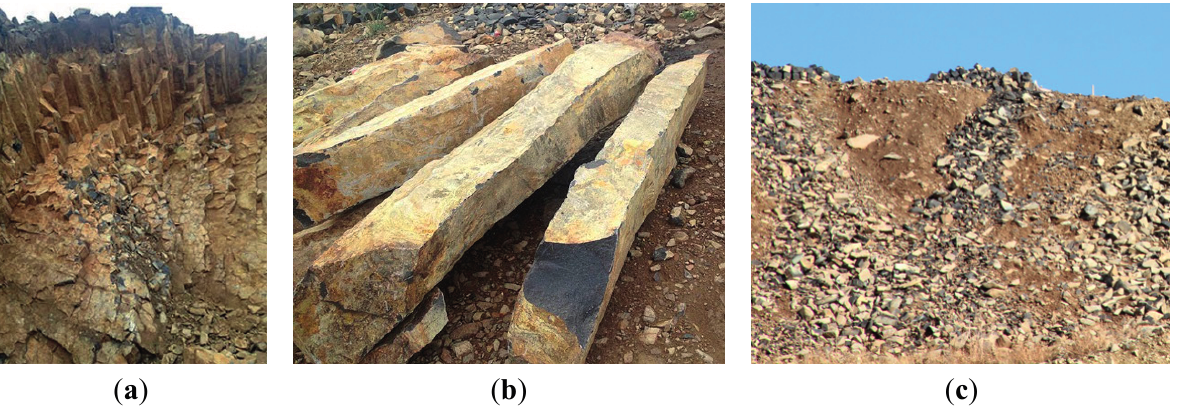
Figure 1. Location of the operational basalt quarry and the waste-rock dumpsite.